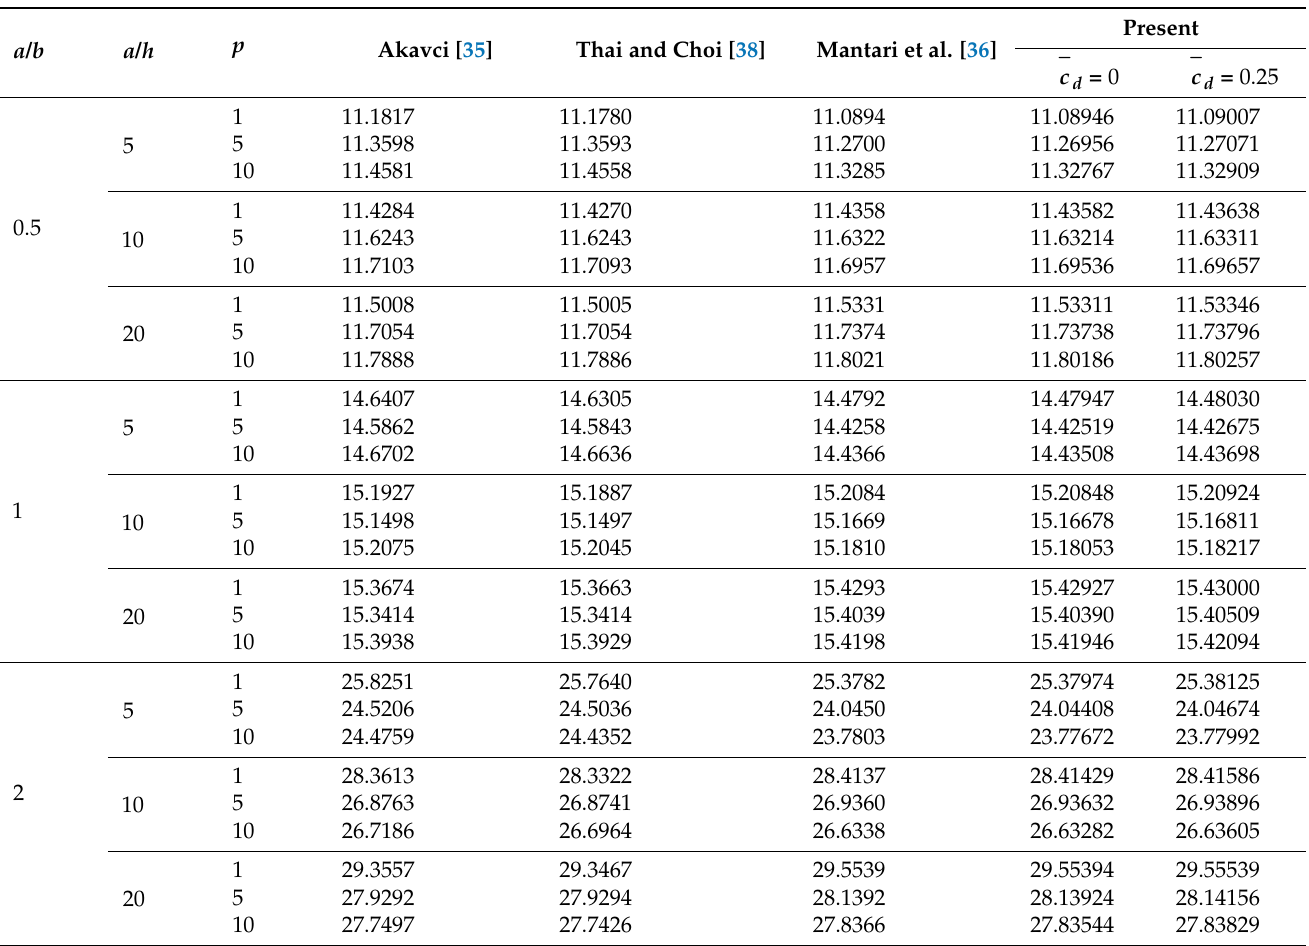
(cid:1)(cid:112) (cid:0) ω a 2 / h ρ m / E m for Al/Al 2 O 3